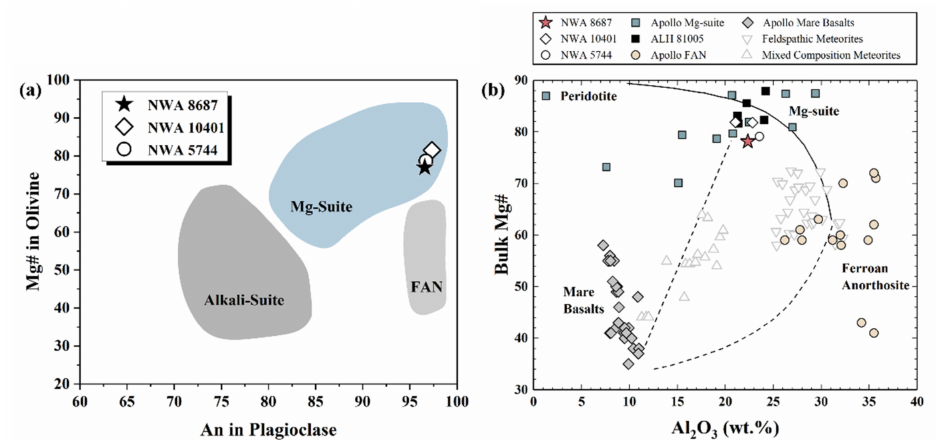
Figure 12. ( a ) Mg# in olivine versus An in plagioclase for NWA 8687 and pairs NWA 5744 and NWA 10401 (after Ref. [13]). ( b ) Bulk Mg# versus Al 2 O 3 content for NWA 8687 and other lunar samples (after Refs. [15,16,32] and references therein). Lines show mixtures among four endmembers: a hypothetical magnesian peridotite, Mg-suite rocks, ferroan anorthosite, and mare basalts. Data source: NWA 5744 [32], NWA 10401 [15], ALH 81005 [16], and other lunar meteorites [33]; Apollo Mg-suite [68], FAN, and mare basalts